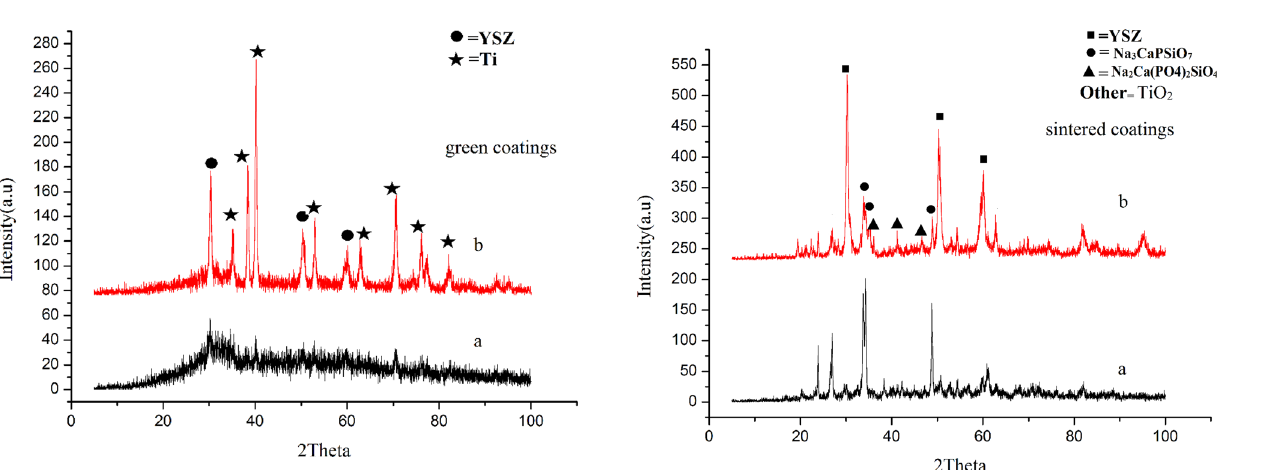
Fig. 6 XRD pattern of sintered coating of bioactive glass and bioac- tive glass-YSZ composites